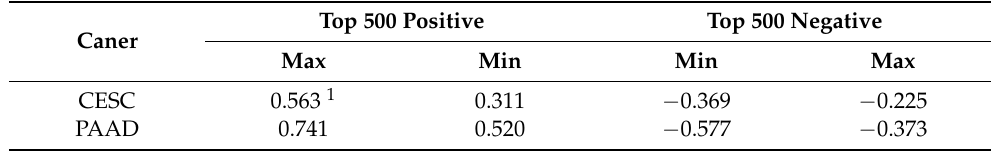
Table 1. POLI vs. other gene correlation ranges in CESC and PAAD. Caner